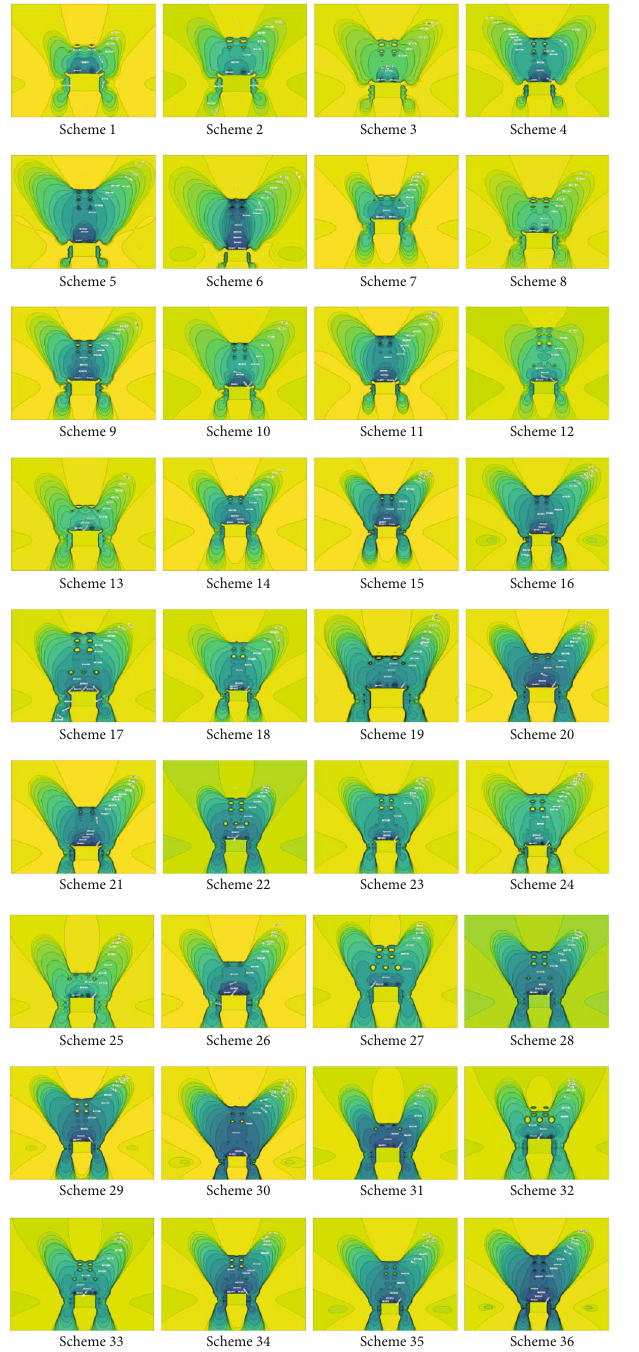
Figure 9: Stress fi eld cloud chart of di ff erent support schemes.